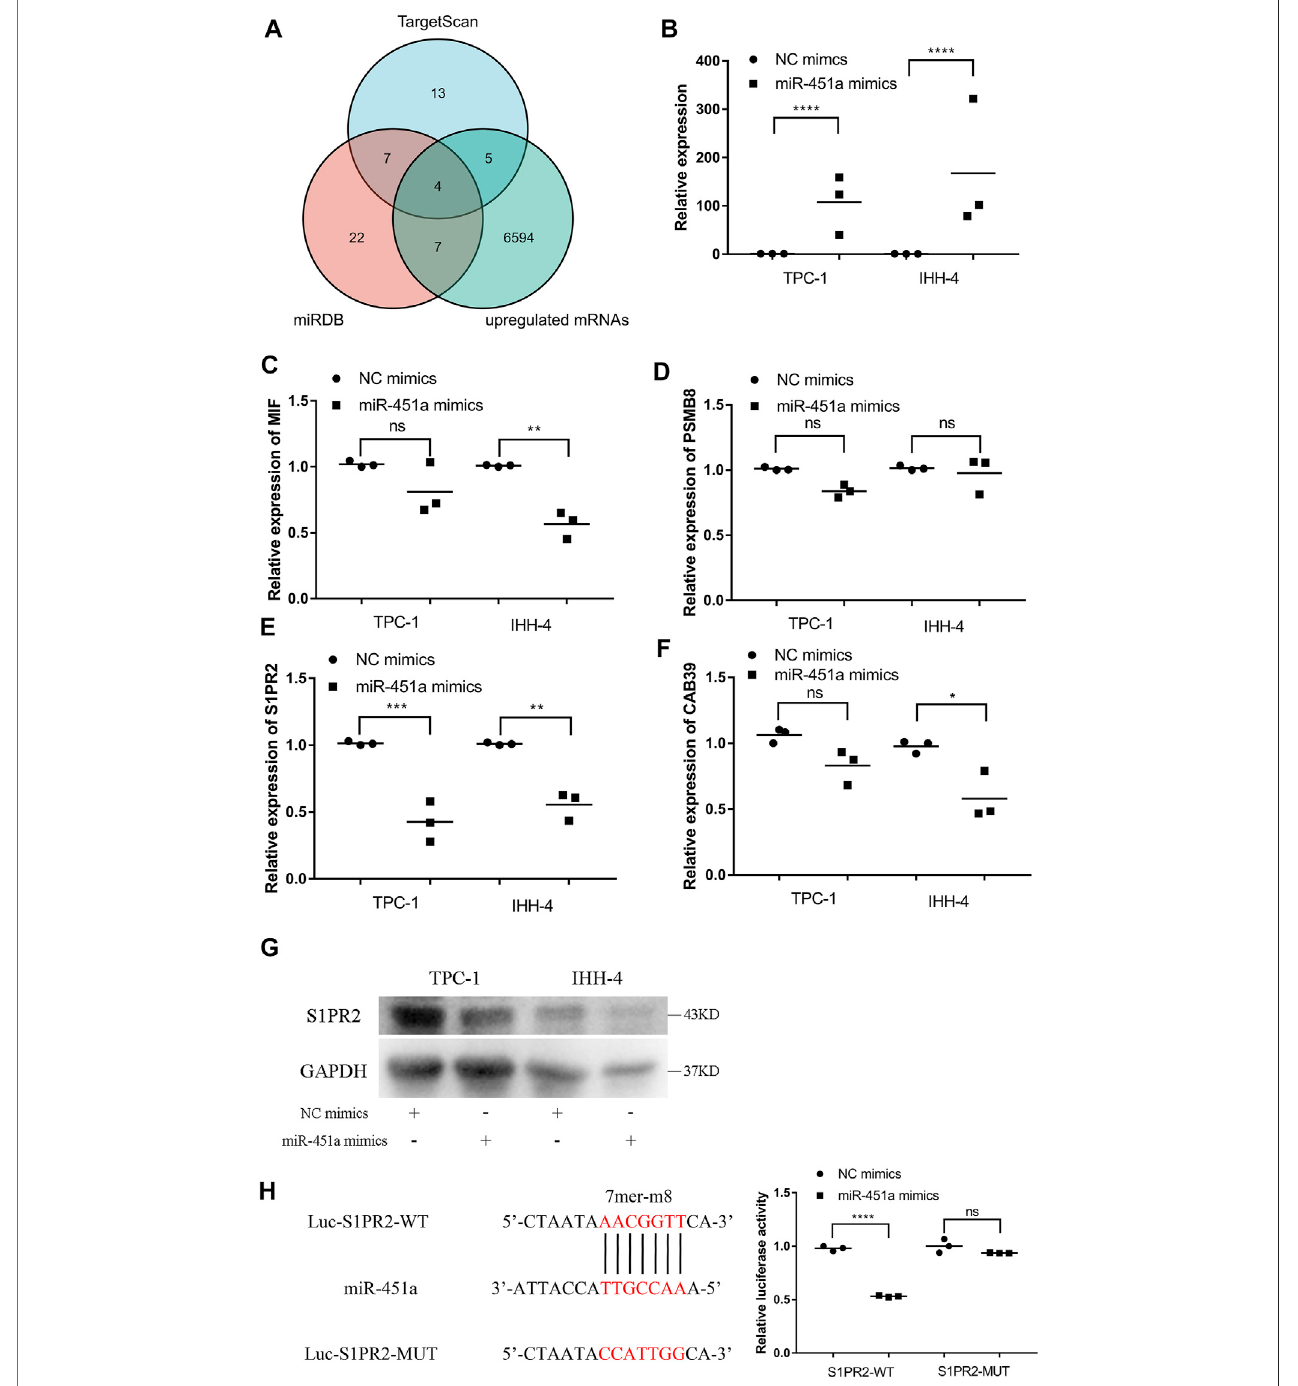
FIGURE5| miR-451atargeted S1PR2 inPTC cells. (A) Vennplotofthreedatabases,includingTargetScan, miRDB, andupregulated mRNAsinTCGA-THCA. (B) The expression of miR-451a in TPC-1 and IHH-4 cells with the transfection of miR-451a mimics ( n = 3). (C) The expression of MIF in TPC-1 and IHH-4 cells with or without miR-451a mimics by qRT-PCR ( n = 3). (D) The expression of PSMB8 in TPC-1 and IHH-4 cells with or without miR-451a mimics by qRT-PCR ( n = 3). (E) The expressionofS1PR2inTPC-1andIHH-4cellswithorwithoutmiR-451amimicsbyqRT-PCR( n =3). (F) TheexpressionofCAB39inTPC-1andIHH-4cellswithor without miR-451a mimics by qRT-PCR ( n = 3). (G) The expression of S1PR2 protein in TPC-1 and IHH-4 cells with or without miR-451a mimics by western blot assay. (H) A putative interaction site with miR-451a in S1PR2 was predicted and veri fi ed by dual-luciferase reporter assay in TPC-1 cell ( n = 3). * p < 0.05; ** p < 0.01; *** p < 0.001; **** p < 0.0001.